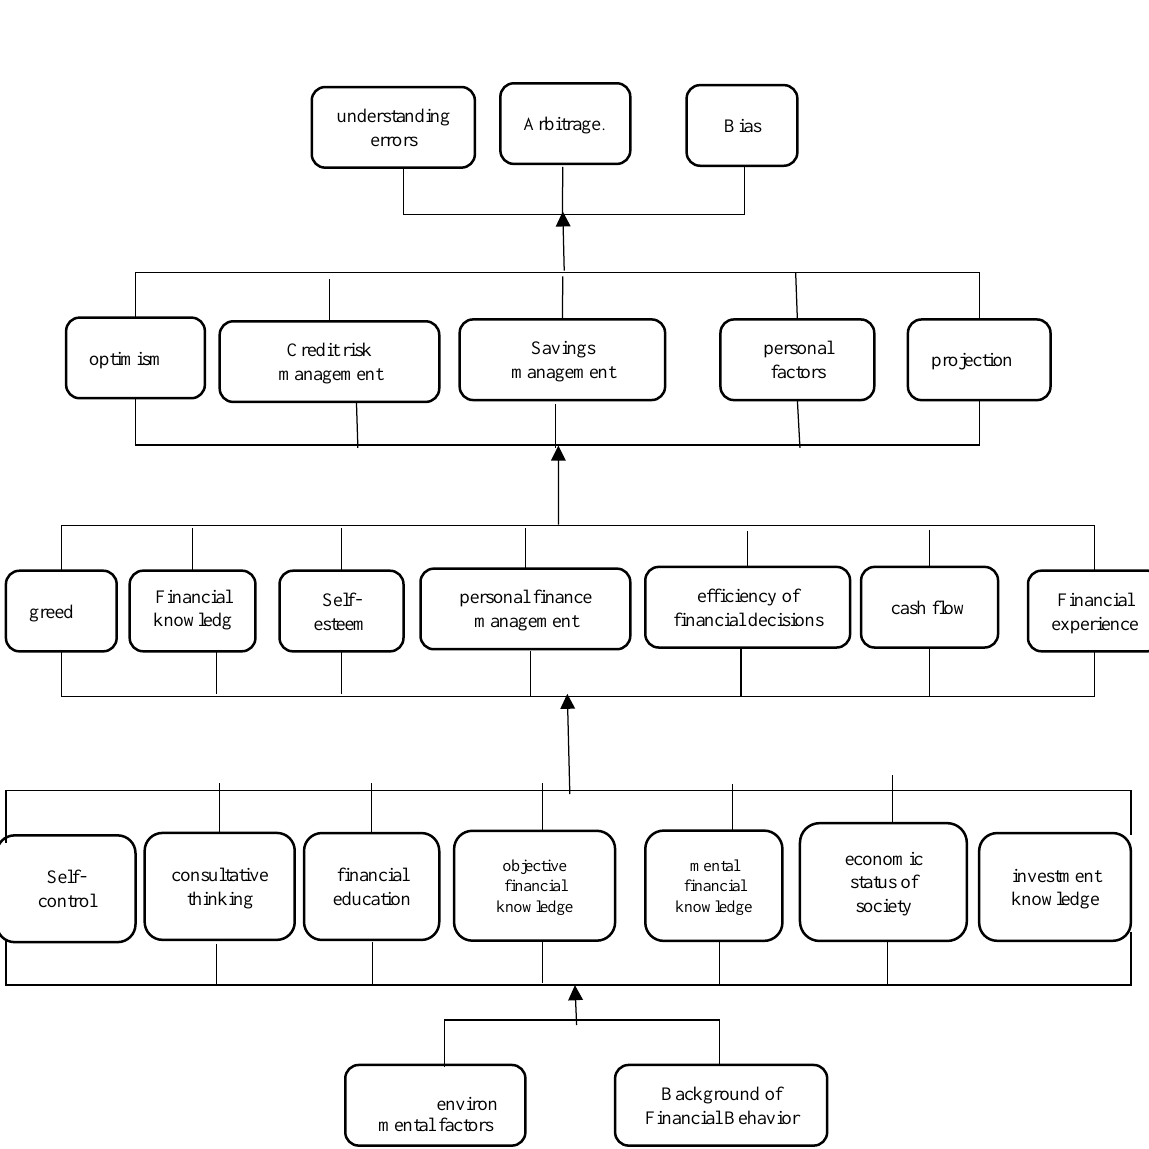
Figure 2. The project ISM